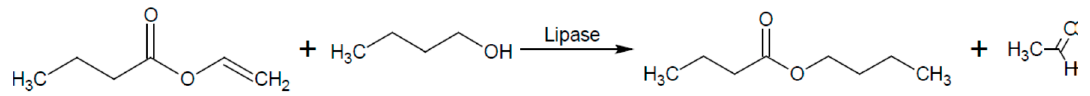
Figure 2. Synthesis of butyl butyrate from vinyl butyrate and 1-butanol catalyzed by CaLB.